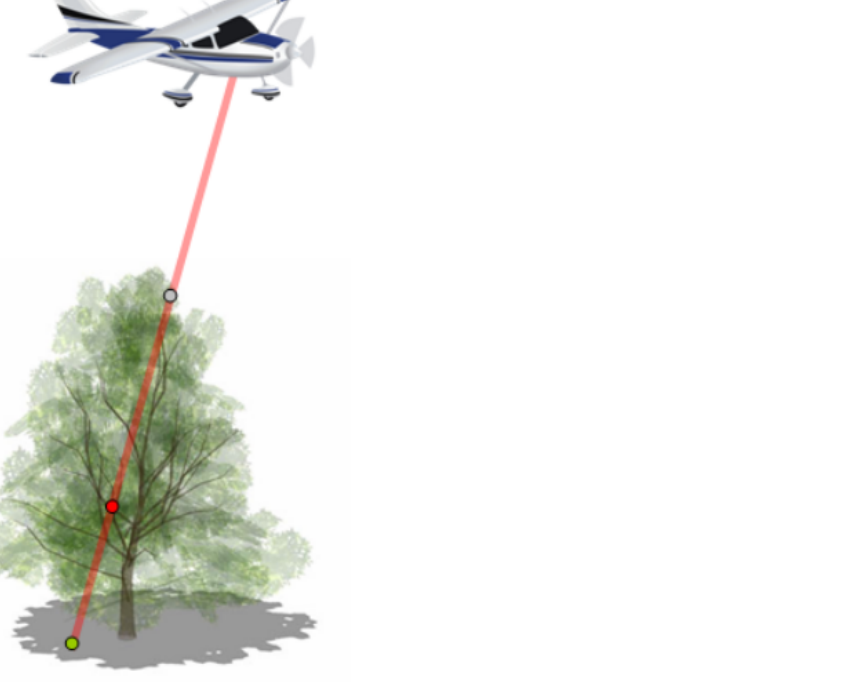
Figure 2. Aerial vehicle equipped with a LiDAR sensor. The first reflection (gray dot) is used for surface mapping and the last reflection (green dot) is used for terrain